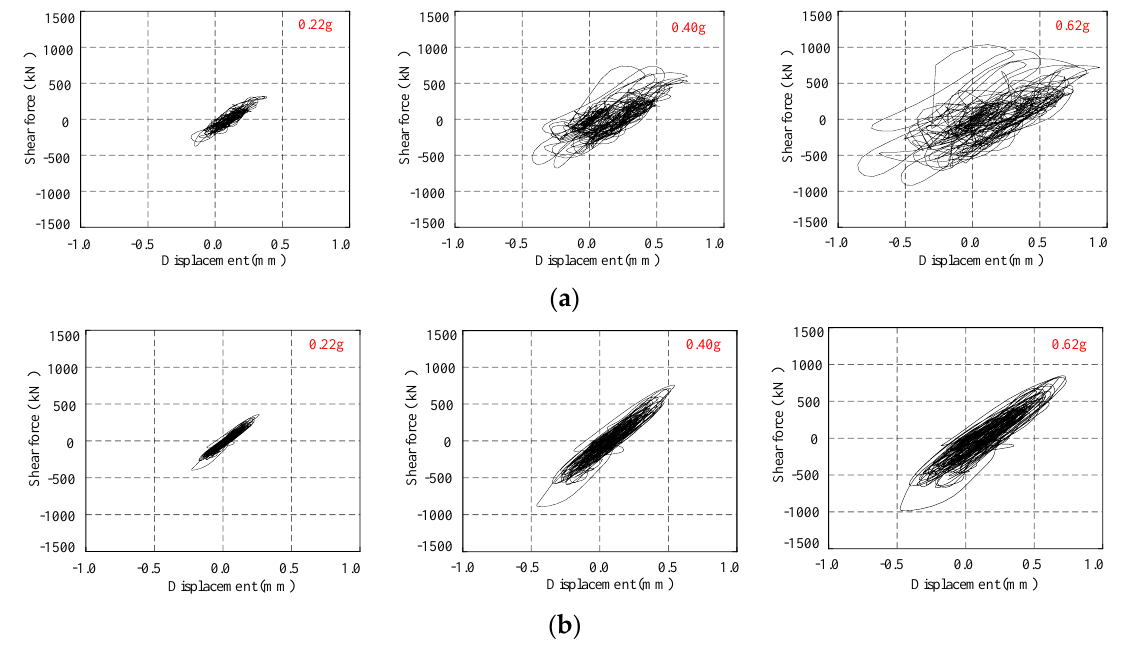
Figure 13. Hysteresis curve of the star-type grid concrete wall structure. ( a ) Lander ground motions, ( b ) Wolong ground motions.